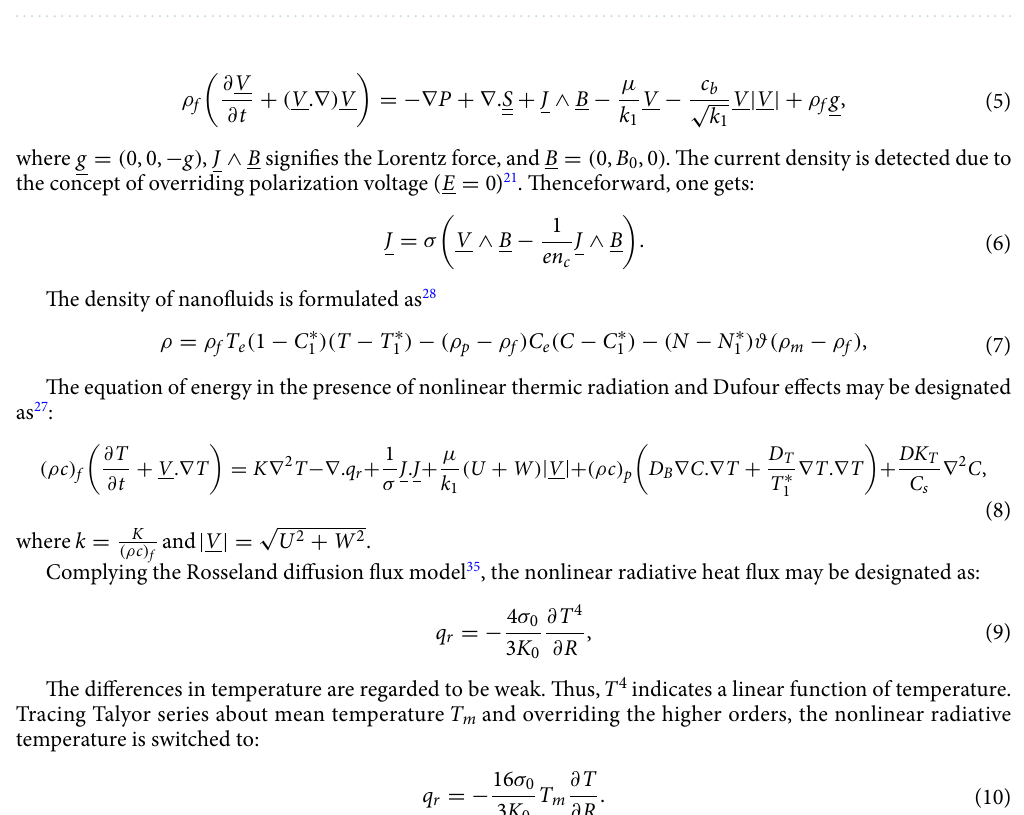
Figure 1. Description of natural prototype of the